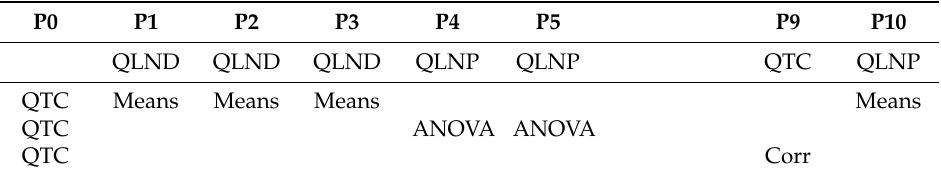
Table 2. Statistical method frequency mode.